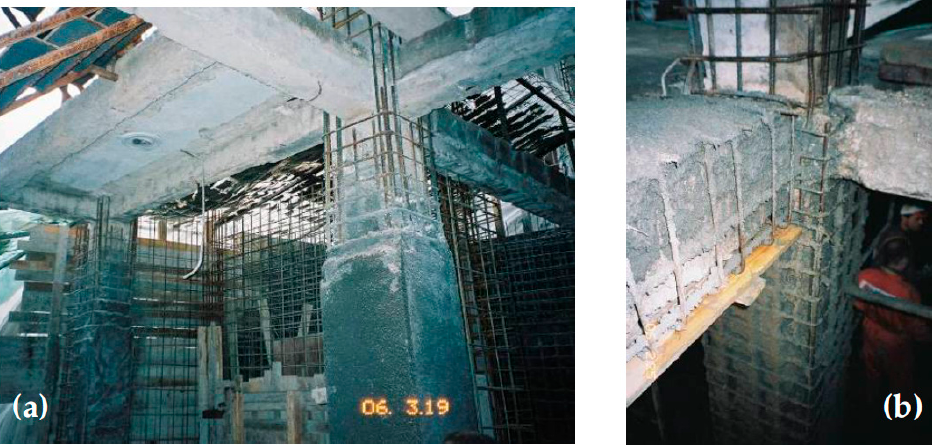
Figure 1. ( a ) RC jacket of columns employing shotcrete (gunite). ( b ) RC jacket of column and beam at the region of their joints employing shotcrete (gunite)